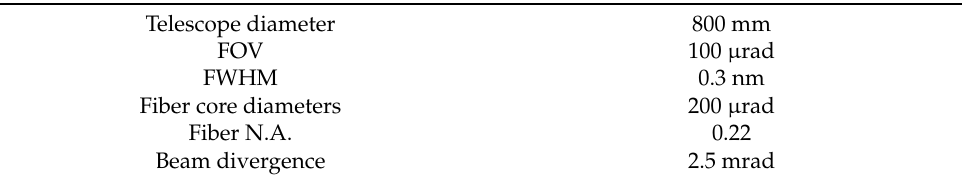
Table 2. Receiver